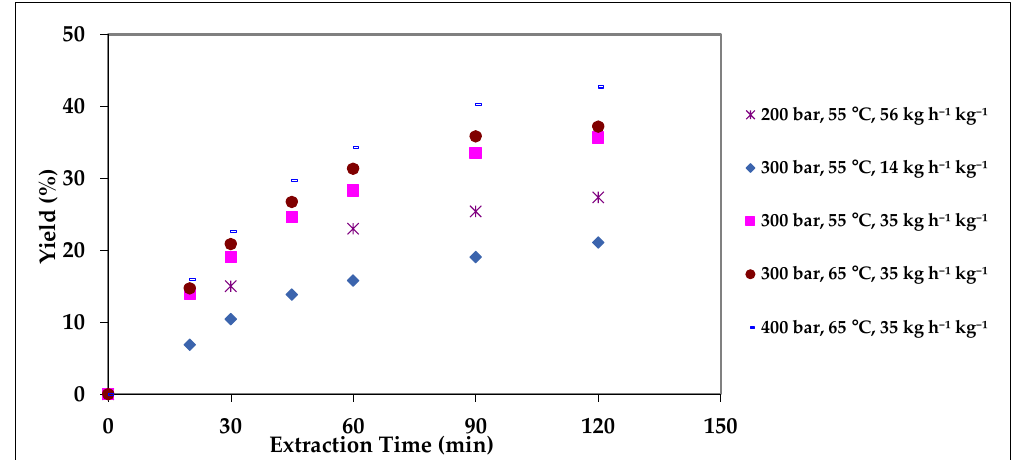
Figure 2. Extraction of palm oil from mesocarp with SCCO 2 .